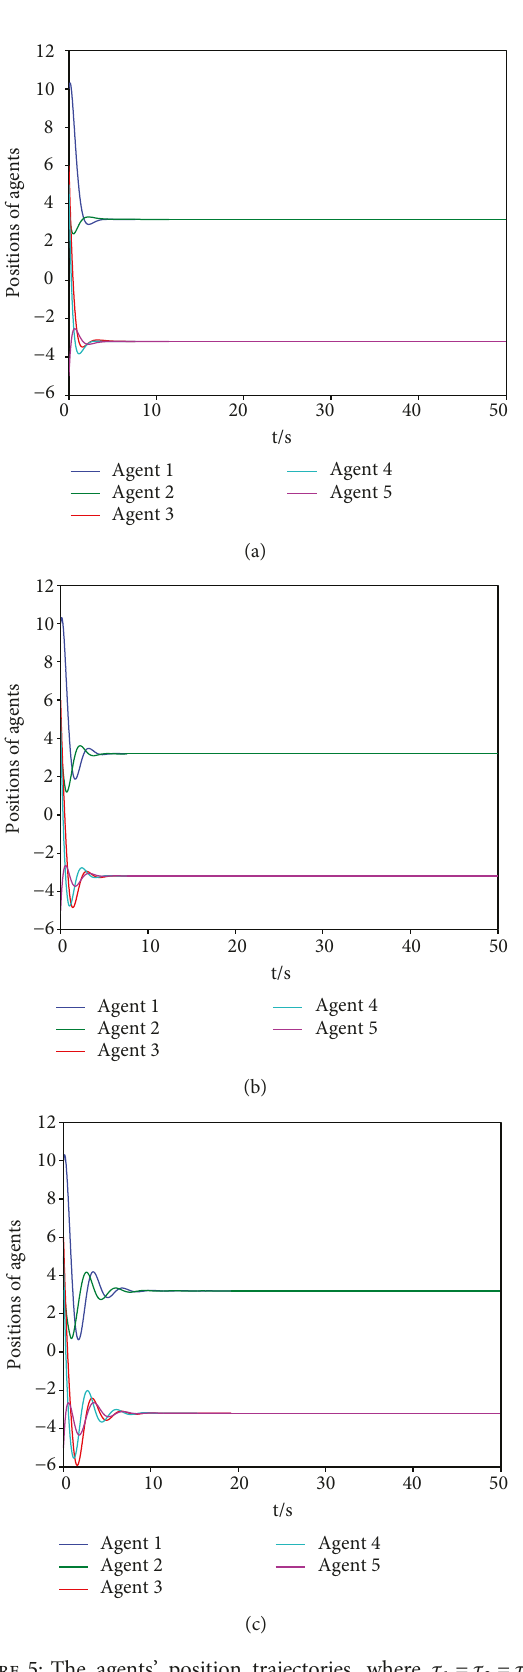
= τ = τ = 1 2 3 = 0 8 . ij